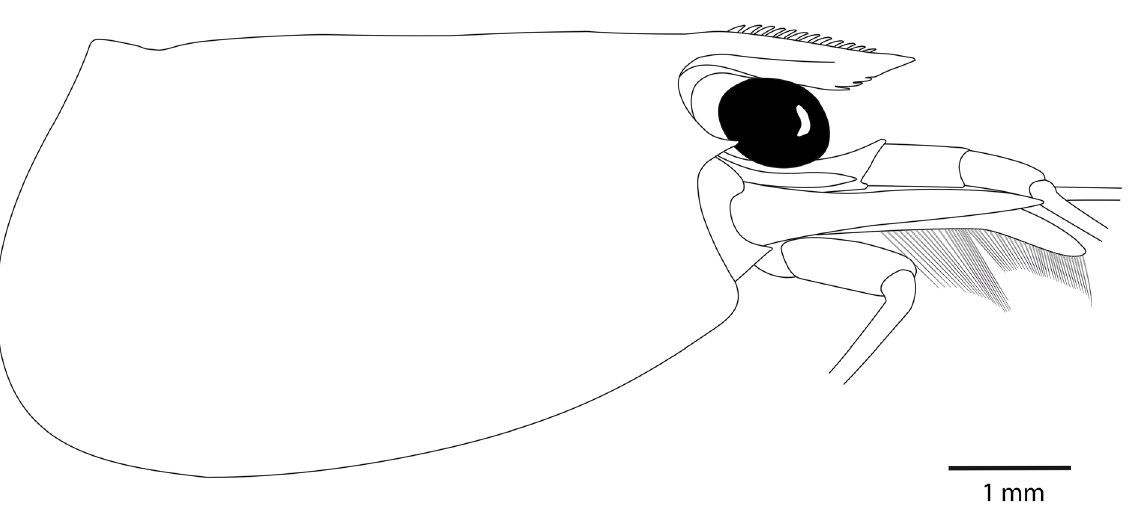
Fig. 16. Caridina tupaia de Mazancourt, Marquet & Keith, 2019. Cephalothorax. MNHN-IU-2018